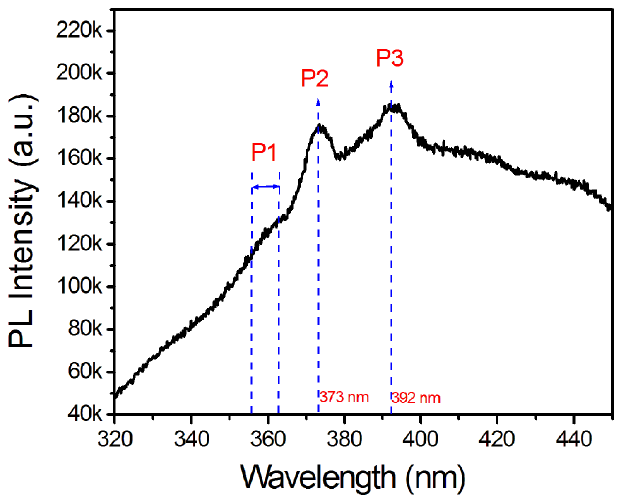
Figure 7. PL measurement at 77 K of In x Ga 1 − x N NWs on a pretreated Ta substrate using Ni as a catalyst